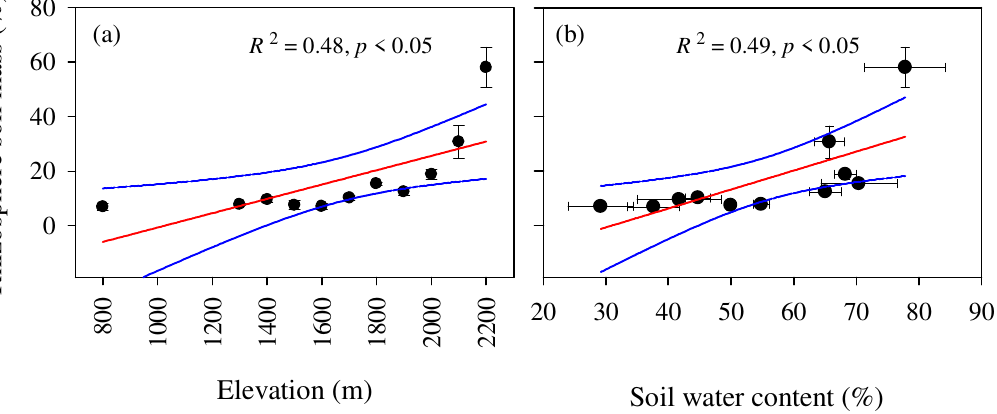
Figure 7. Relationships of the rhizosphere soil mass with elevation ( a ) and soil water content ( b ) ( n = 11). The solid red lines represent linear regression, and the blue lines represent the 95% confidence intervals.